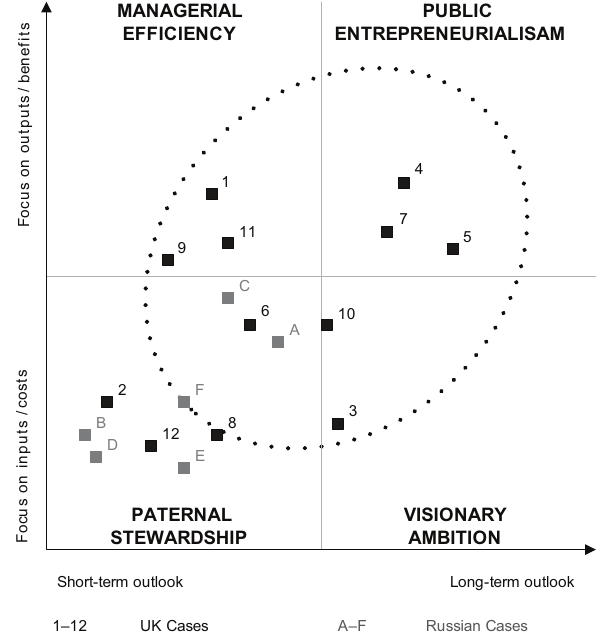
figure 6. Positioning of case studies in the asset management